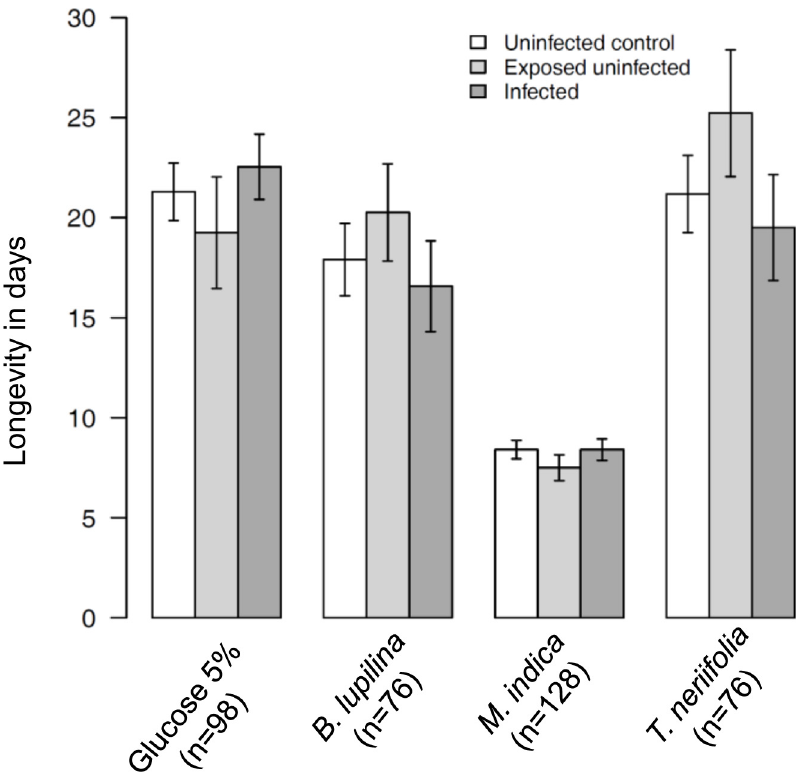
Fig 3. Effects of sugar treatment and infection status on mosquito longevity. Bars show the mean adult longevity ± 1 SE of uninfected control, exposed-uninfected and infected mosquitoes held on one of four sources of sugar. Numbers in brackets indicate, for each sugar treatment, the total number of mosquitoes